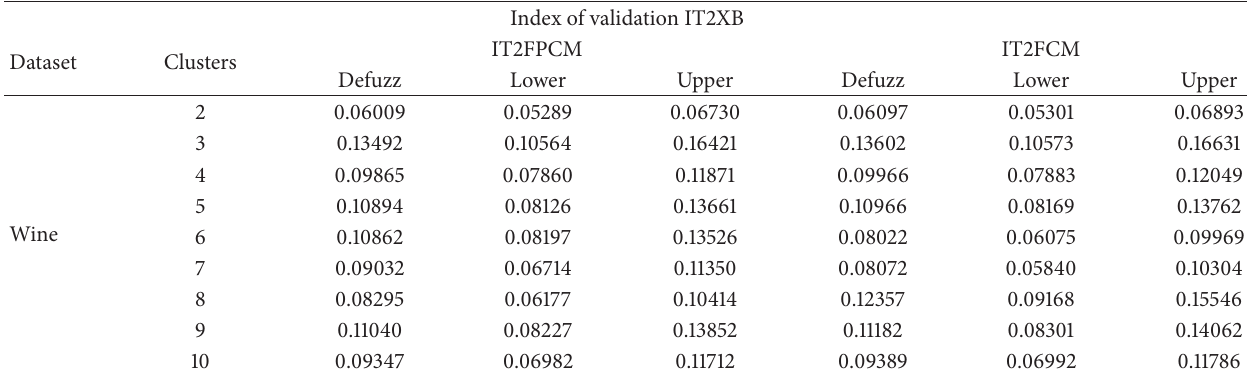
Table 7: Results of the IT2XB validation index to Wine dataset clustering using IT2FPCM and IT2FCM algorithm with 𝑚 = [1.5, 2] and 𝜂 = [1.5, 2.5] as parameters.